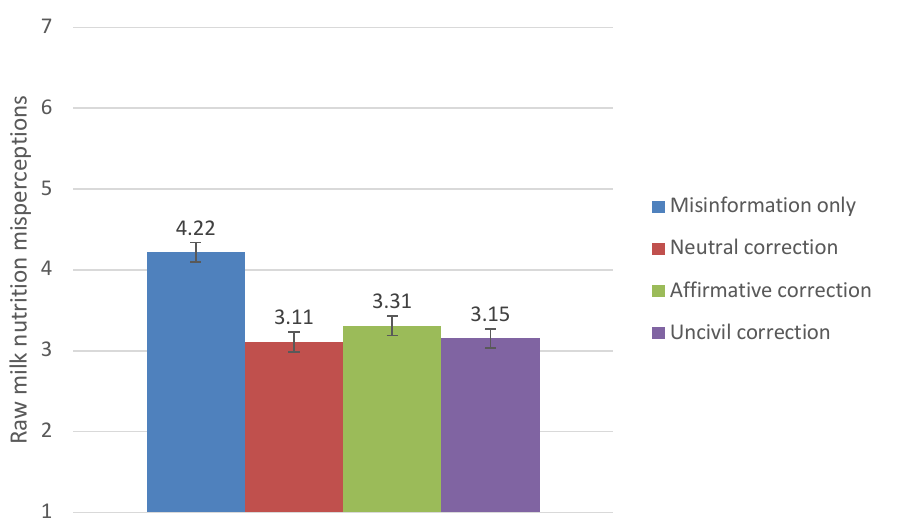
Figure 1. Misperceptions about the Nutritional Value of Raw Milk by Experimental Condition. Note that higher numbers reflect less accurate attitudes towards the nutritional value of raw milk. Each color shows the average for the group. Error bars represent a 95% confidence interval for the